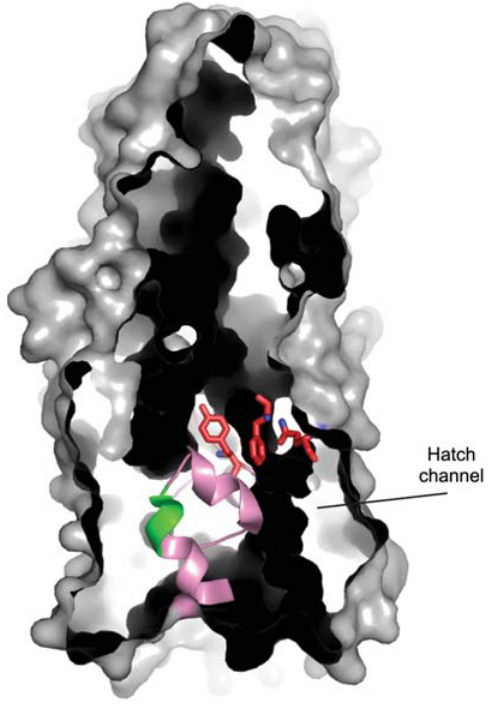
Figure 6 Surface cut-away view of TodX showing a possible transport channel through the hatch domain. Residues Tyr9, Gln83 and Phe100, forming the constriction of this channel, are shown as stick models (red). The location of the NPA sequence of the hatch domain (pink) is shown in